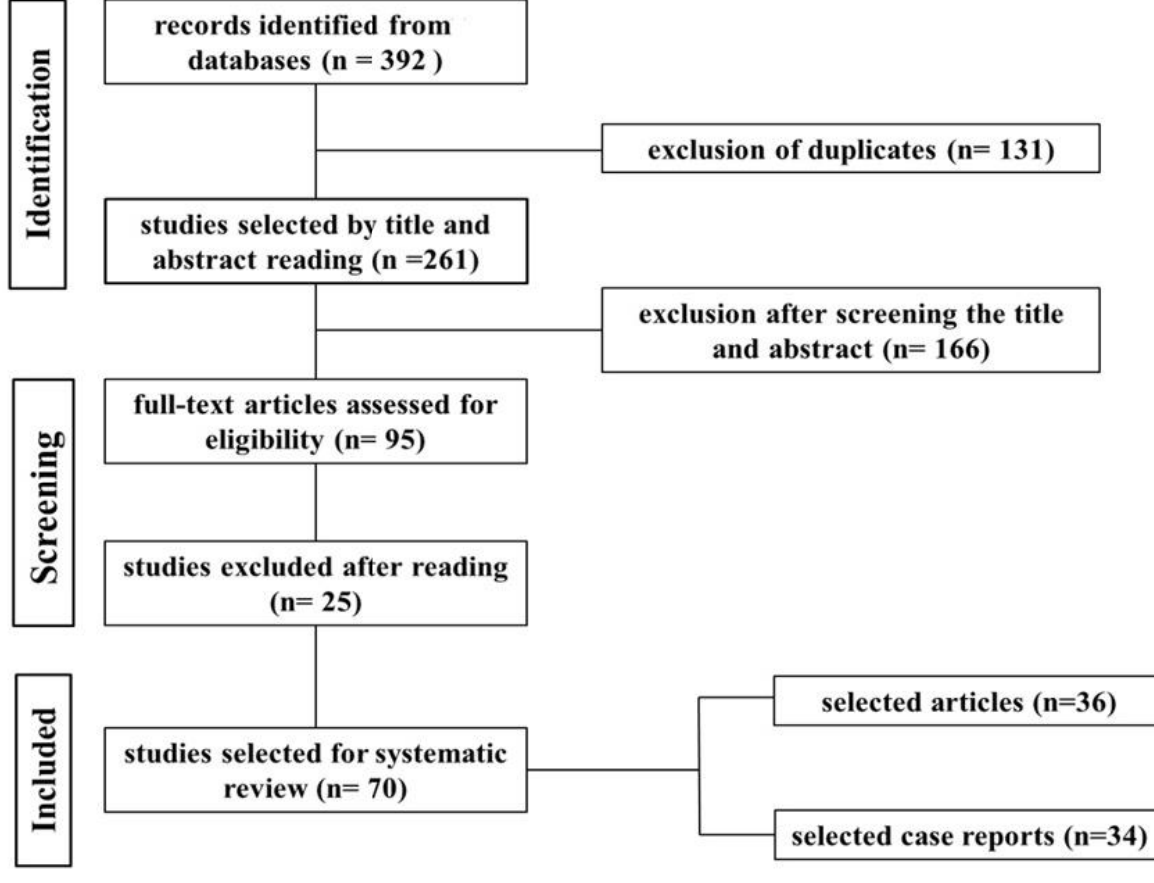
Figure 1. Flowchart of the search, selection, and inclusion of studies in the systematic review based on the PRISMA 2020 guidelines.